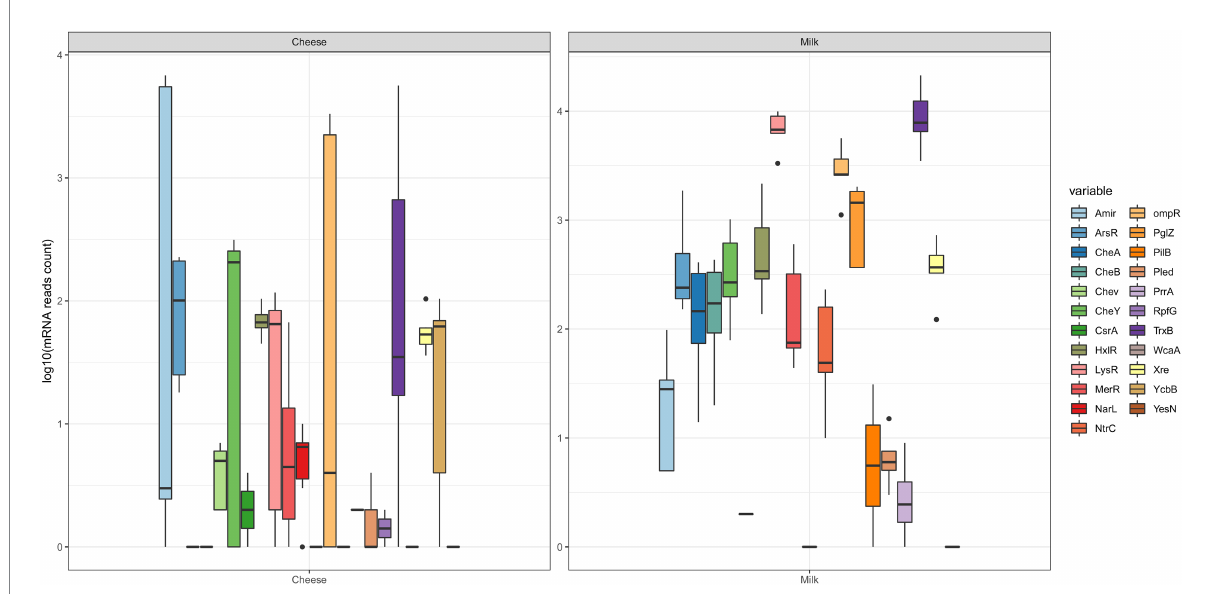
FIGURE 2 Boxplots detailing the variation of gene expression (log 10 read counts of mRNA) for the 23 gene families of Response Regulators ( Amir, ArsR,CheA, CheB, CheC,CheV, CheY, CsrA, HxlR, LysR, MerR, NarL, NtrC, ompR , PglZ, PilB , PleD, PrrA, RpfG, TrxB, XRE, WcaA, YcbB , and YesN ) found in publicly available metatranscriptomic databases for the microbiota of dairy products (milk and cheeses). The horizontal lines inside the boxes indicate the median values, and the dots outside the boxes indicate outliers. Reads from single samples (lines) were obtained in cheeses for the effectors CheA , NtrC , PglZ , PilB , WcaA , and YesN , and there was no detection of PrrA. In milk, single lines were obtained for CsrA, NarL with no detection of CheV, RpfG, Wcaa, and YesN